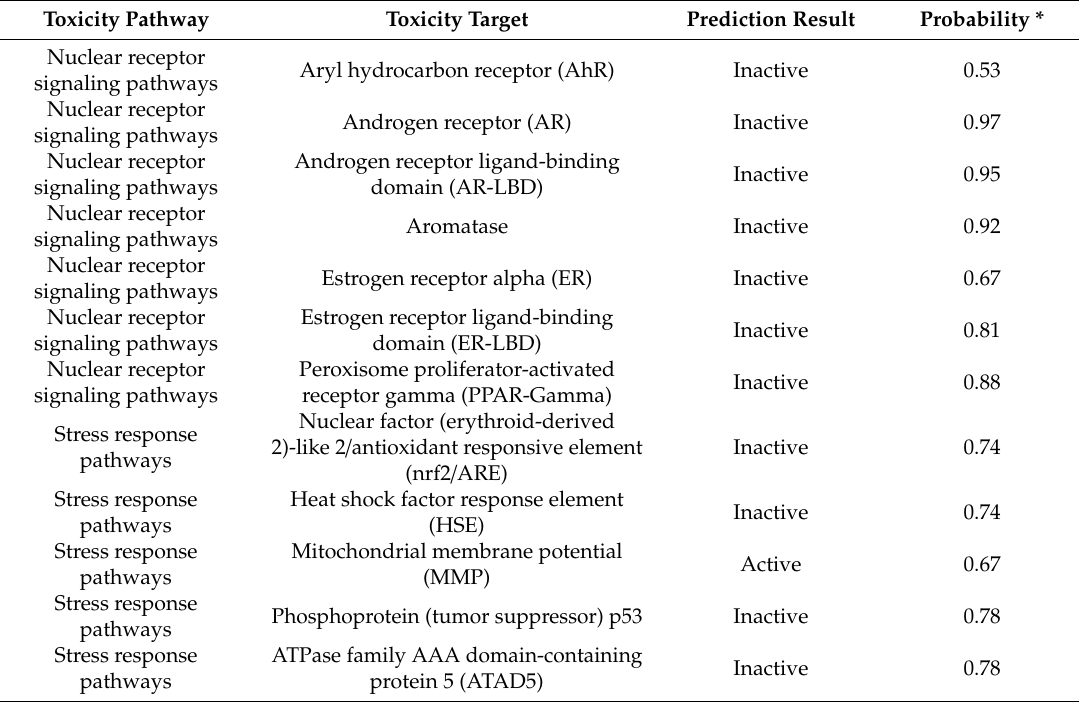
Table 5. The prediction of KTU-286 in silico interaction with major human toxicity targets. Toxicity